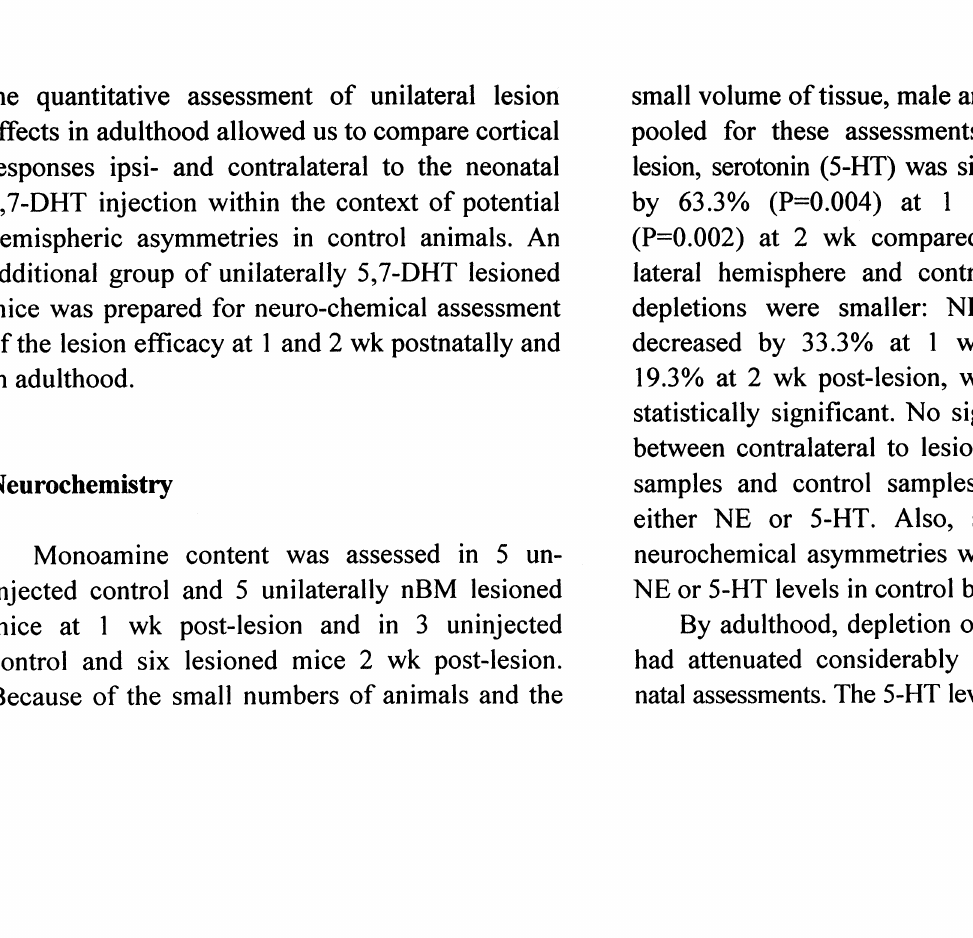
Digitized image of a coronal section through the somato-sensory cortex of an uninjected control mouse. Note that boundaries between cortical layers are clearly discemable. The white lines show the computer overlay of measurements of individual cortical layers and total layer width as performed on the MCID